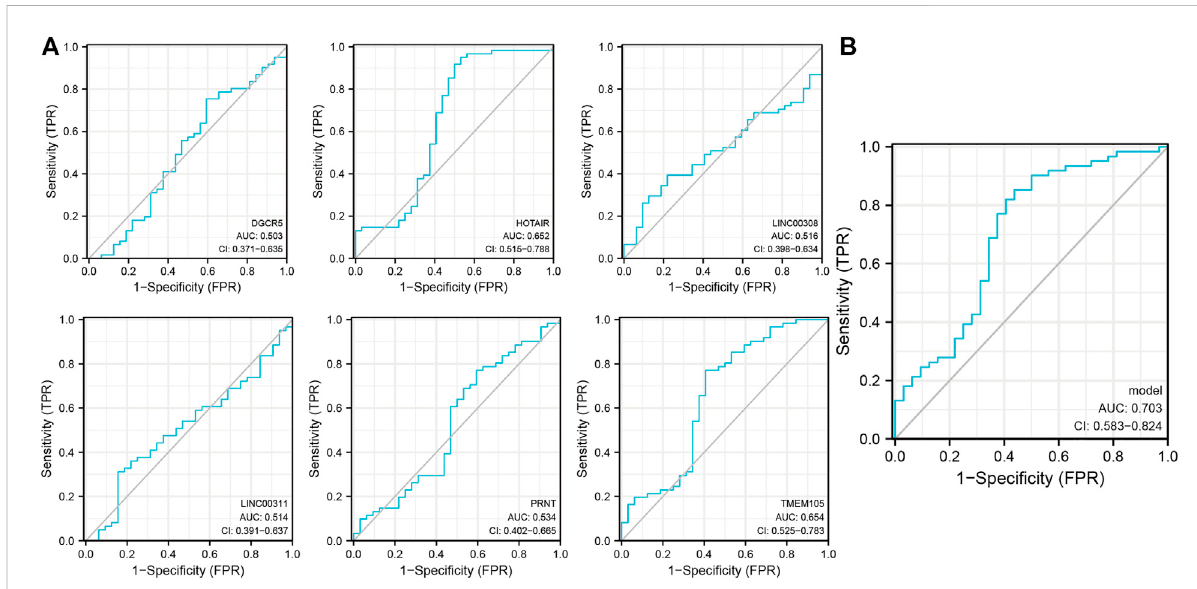
FIGURE 1 Single-andcombined-indicatorreceiveroperatingcharacteristiccurve(ROC)curvesofpyroptosis-relatedlongnon-codingRNA(lncRNAs)for nasopharyngealcarcinoma(NPC)diagnosis. (A) .Single-indicatorROCcurvesfor DGCR5 , HOTAIR , LINC00308 , LINC00311 , PRNT ,and TMEM105 for NPC diagnosis; (B) . Six lncRNAs as co-diagnostic